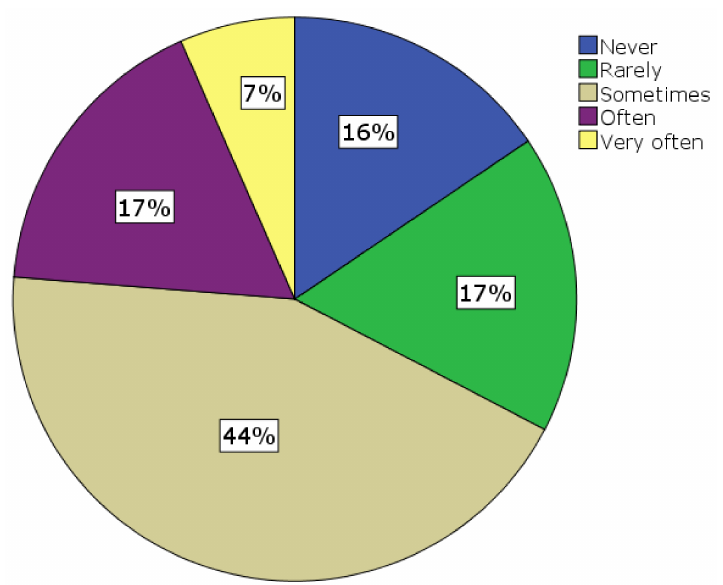
Figure 4. How often do time constraints prevent you from walking in Galway?